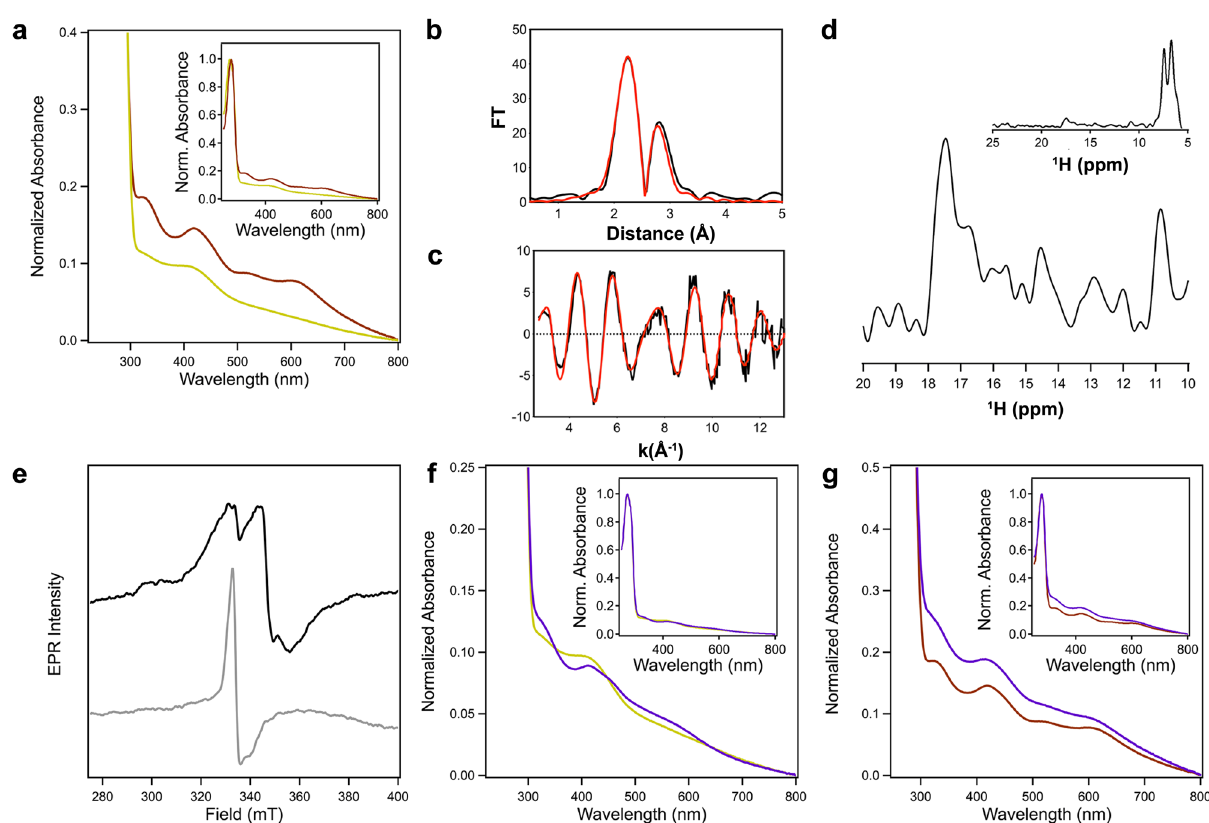
Fig. 3 | Characterization and reactivity of the [4Fe-4S] cluster of Sc ATE1. a Reconstitutionof Sc ATE1underanoxicconditionsyieldsanelectronicabsorption spectrum (yellow)consistent withthepresenceofa[4Fe-4S] clusterthat is distinct from the [2Fe-2S] cluster obtained under oxic conditions (brown). b , c EXAFS of Sc ATE1 reconstituted under anoxic conditions. The Fourier transformed data ( b ) and raw EXAFS ( c ) areconsistent with the presenceofa [4Fe-4S] cluster. The black traces represent the experimental data, while the red traces represent the EXCURVE- fi tted data. 1Å=0.1nm. d Paramagnetic 1D 1 H NMR data reveal three weak hyper fi ne shifts at 10.8 ppm, 14.5 ppm, and 17.5 ppm in the spectrum of Sc ATE1 reconstituted under anoxic conditions, consistent with a [4Fe-4S] 2+ cluster. Insetshowstheentire1D 1 HNMRregionfrom5-25ppm. e